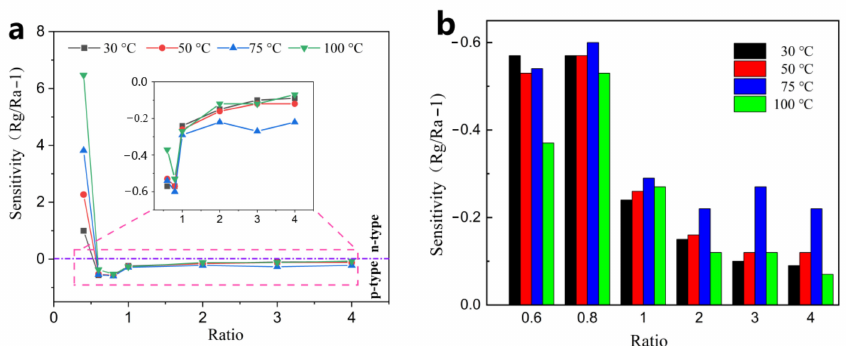
Figure 10. ( a ) response of the ZnO/x% rGO (x = 0.4, 0.6, 0.8, 1.0, 2.0, 3.0, 4.0) to 4 ppm at 30–100 ◦ C; ( b ) Response curves of the ZnO/x% rGO (x = 0.6, 0.8, 1.0, 2.0, 3.0, 4.0) in the subsidiary vignette.